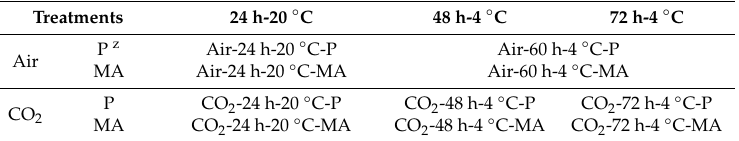
Table 1. Treatment